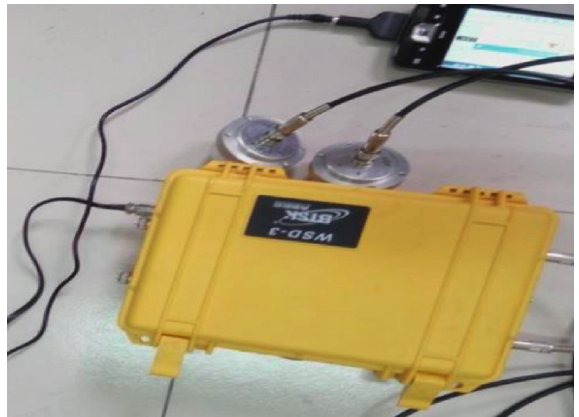
Figure 1: Acoustic velocity testing instrument.